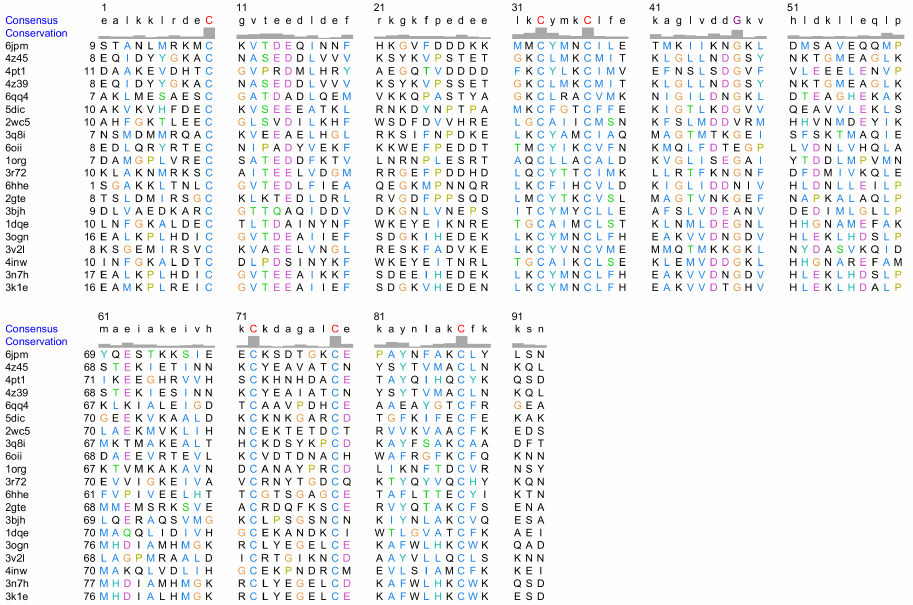
Figure A2. Same as Figure A1 after removing columns containing gaps.